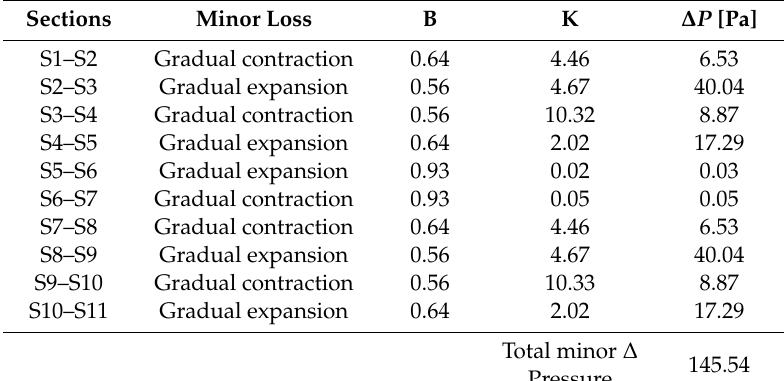
Table 4. Minor pressure losses along the fluidic system as calculated with the macroscopic approach.